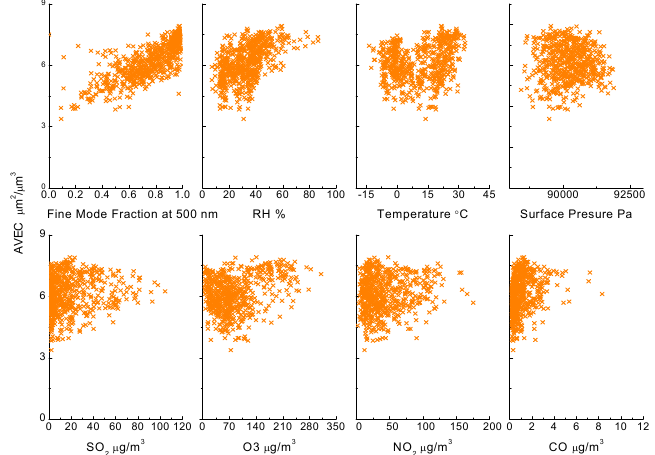
Figure 7. Relationship of averaged volume extinction coefficient (AVEC) with eight likely influence factors (year = 2015, n = 637).